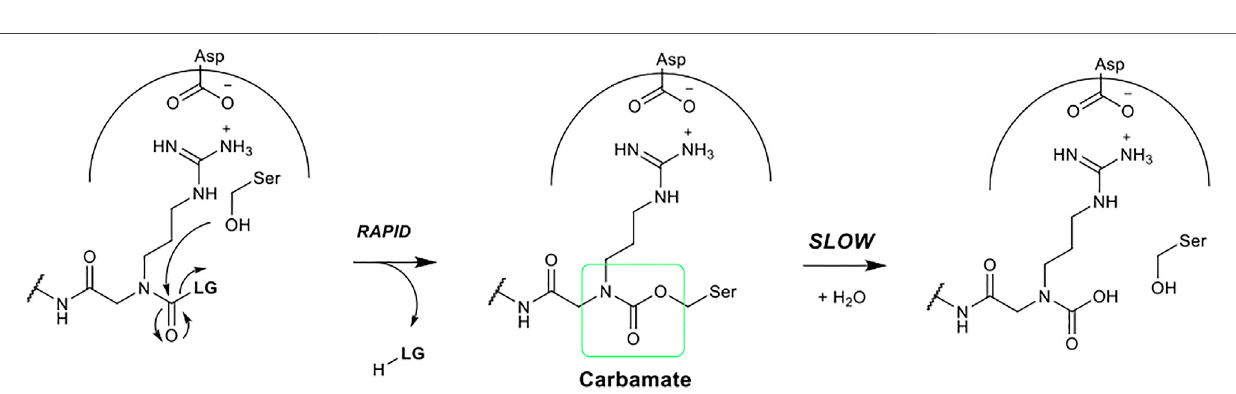
FIGURE 5 | Postulated mechanism of serine protease inhibition by N -alkyl glycine inhibitors.